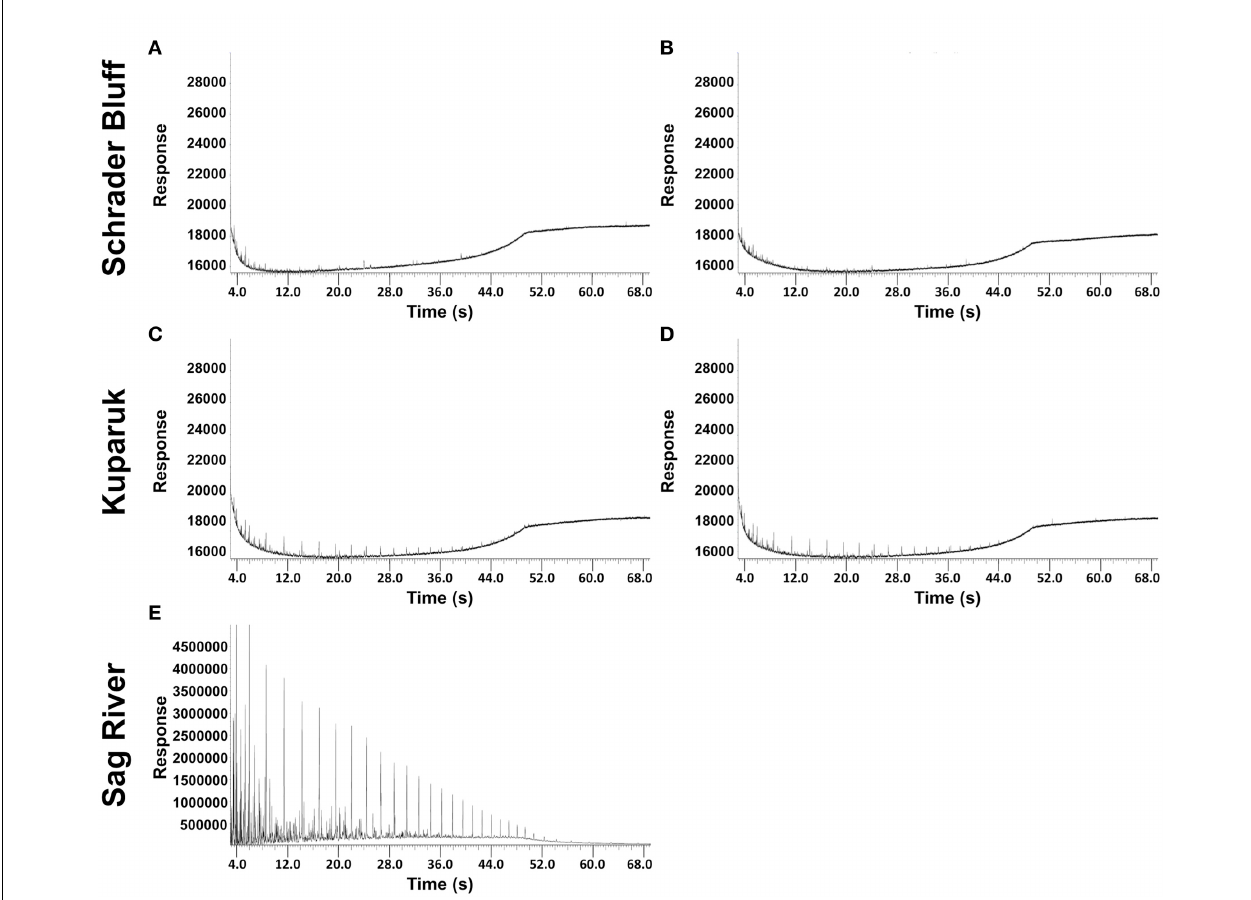
FIGURE 3 | Chromatograms for volatile fractions of North Slope oil from the Schrader Bluff reservoir (SB1 and SB2 are A,B, respectively), the Kuparuk reservoir (K1 and K2 are C,D, respectively) and the Sag River reservoir